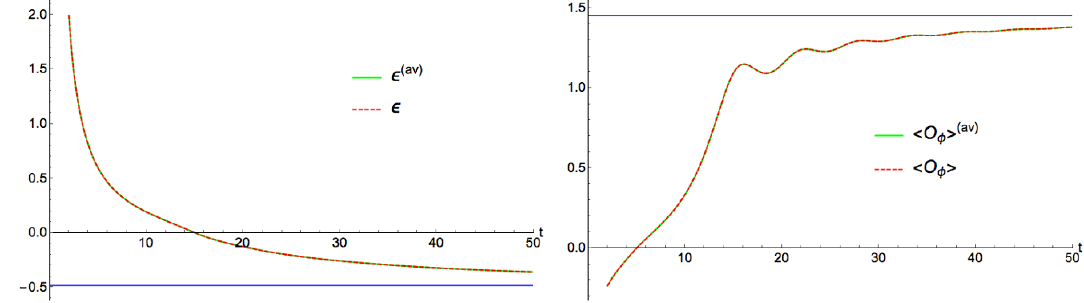
Figure 12 . Comparing the mean value of energy density and expectation value of the scalar (cid:12)eld for inhomogenous evolution (green solid line) with the homogenous one (dashed red line) for the class A potential. The blue horizontal lines correspond to the smallest black hole solutions which we expect to be the late time state of the boost invariant